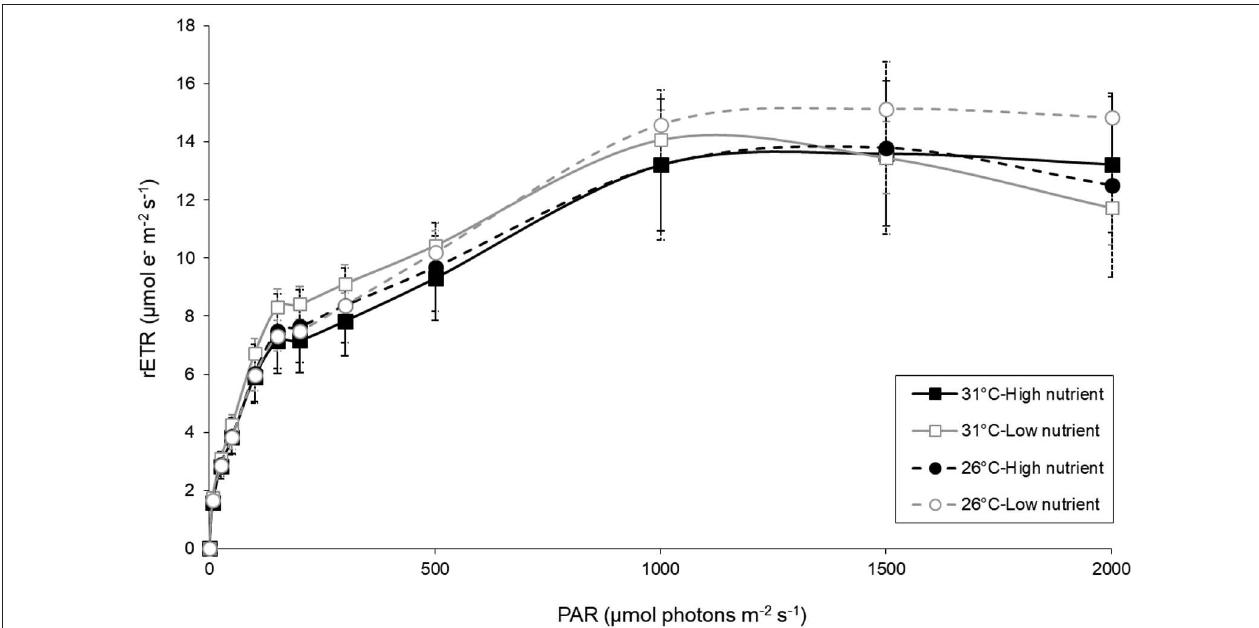
FIGURE 3 | Rapid light curves. Relative electron transport rate (rETR) as a function of photosynthetic active radiation (PAR) on leaves of Enhalus acoroides seedlings in the four different temperature and nutrient treatments at the end of the experiment. Values are mean ± SE ( n =